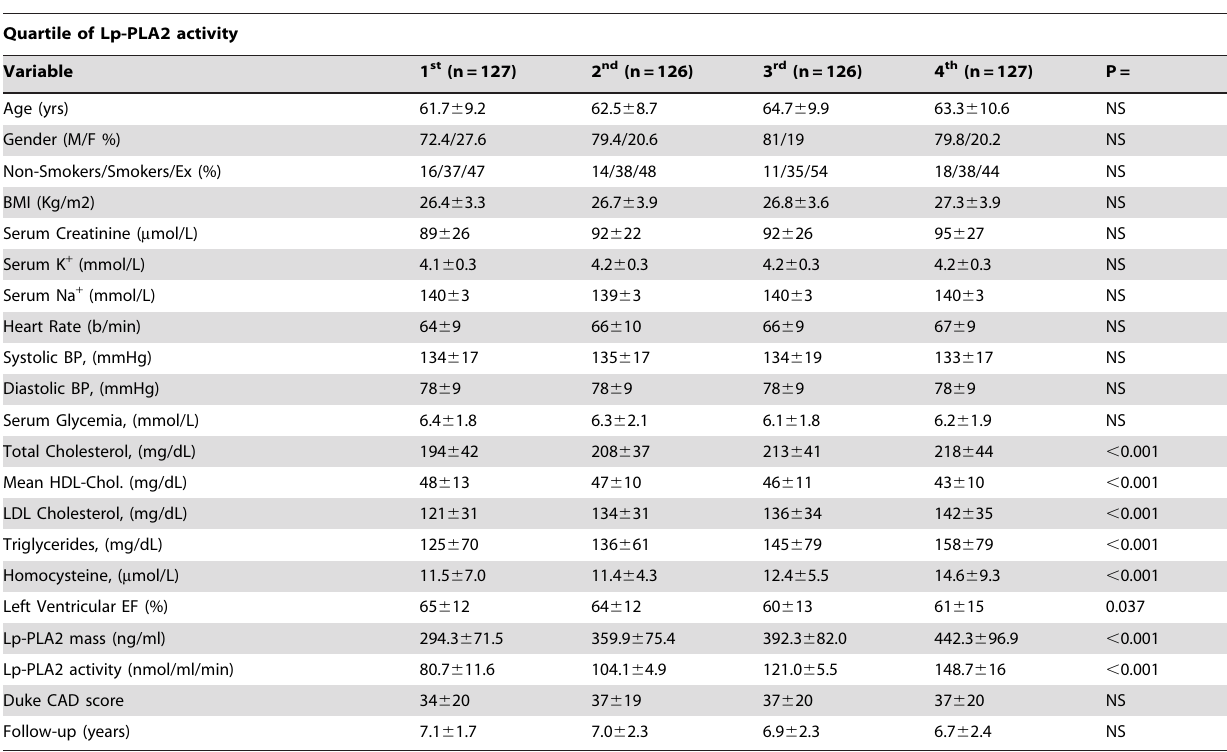
Table 2. Demographic and clinical characteristics of the subjects classified by Lp-PLA2 activity quartiles.